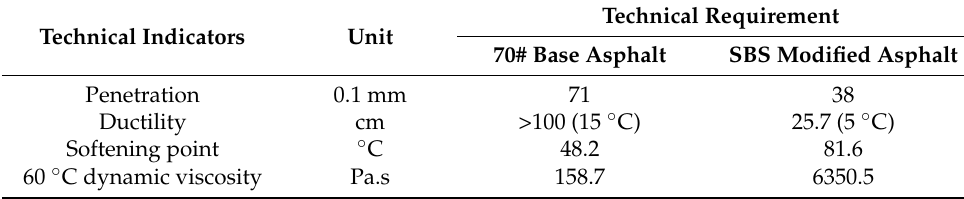
Table 1. Technical indexes of PU asphalt.